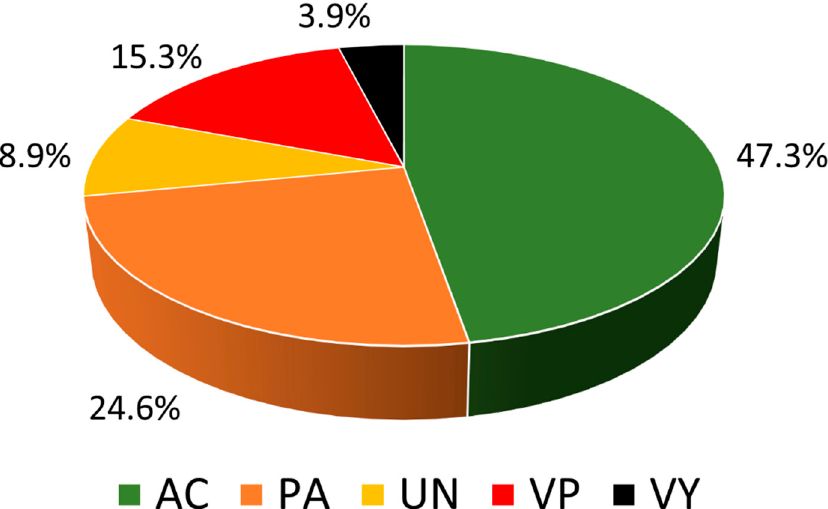
Figure 2. Risk level (percentage classes) expressed for each breeding species (n = 203) in PAV belonging to the Operational Checklist 2010–2019 (see Table 4 for details).